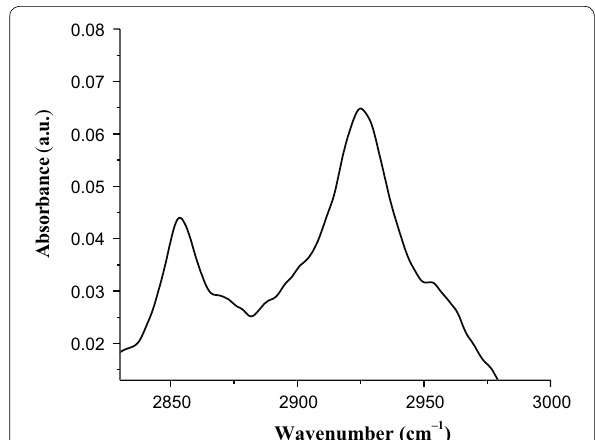
Fig. 3 FT‑IR‑ATR absorption spectrum of green coffee beans dis‑ solved in water